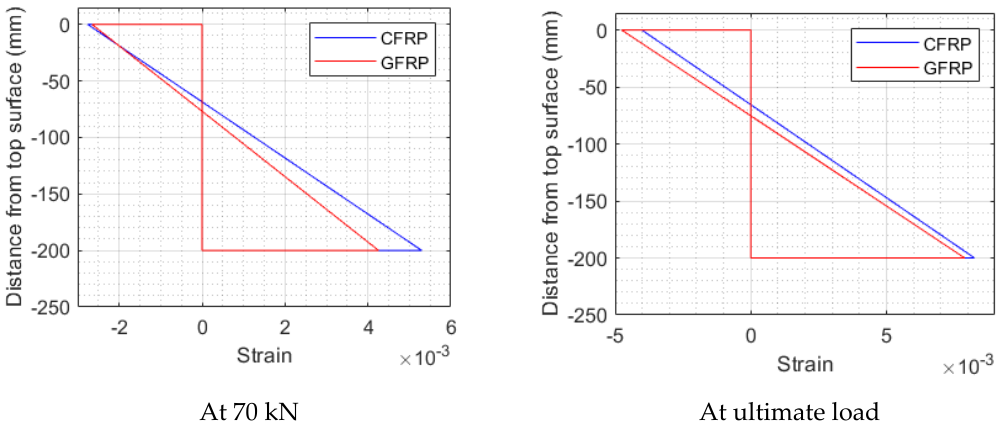
Figure 10. Strain profile (of BCF1 and BGF2) along the cross-section at 70 kN and at ultimate load.